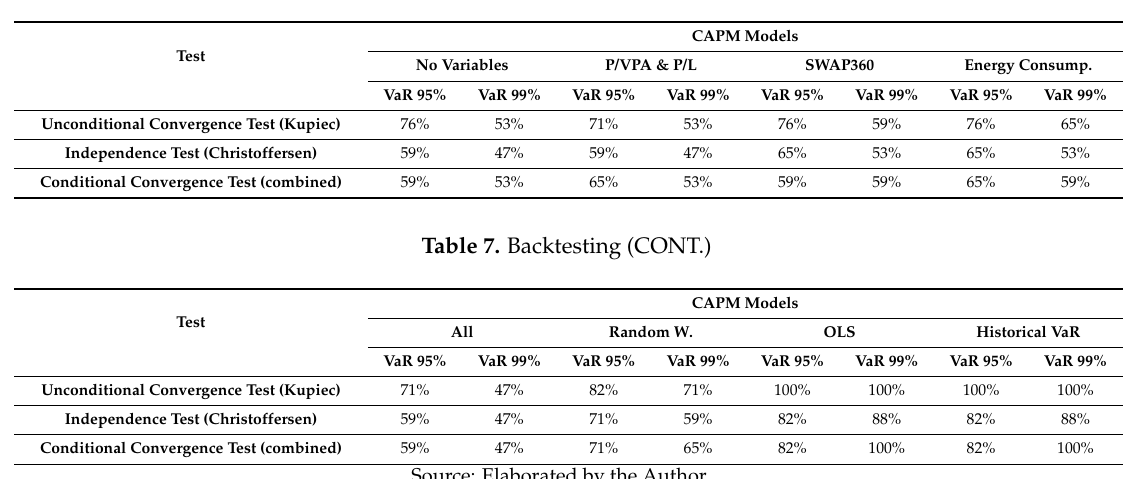
Table 6. Backtesting.